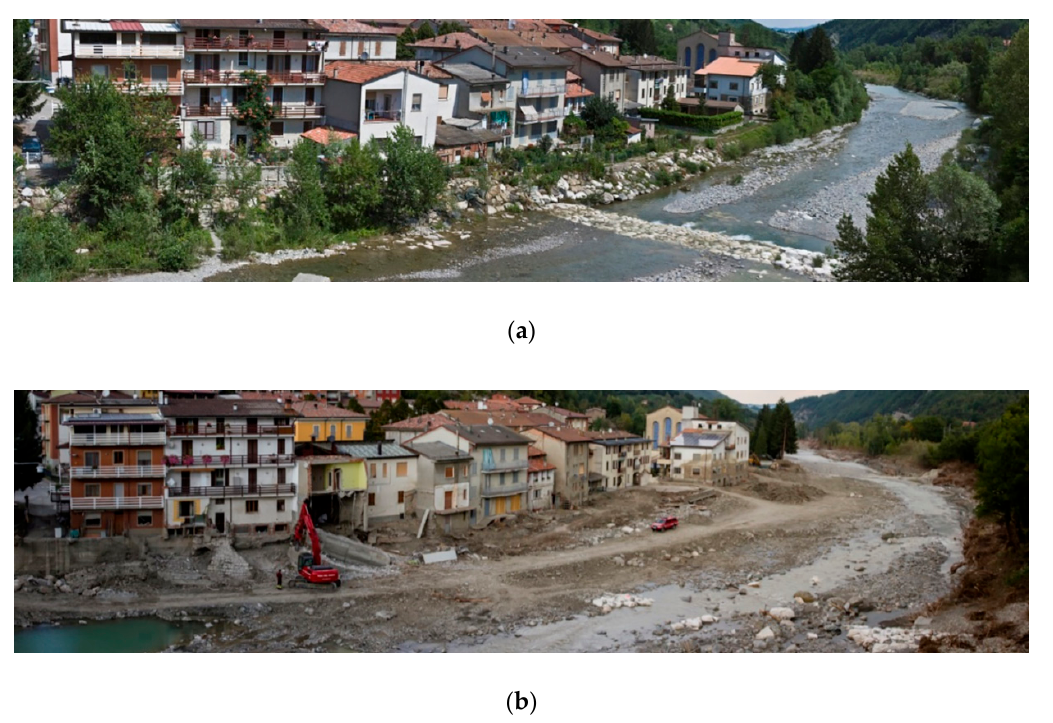
Figure 10. Farini village ( a ) before and ( b ) after the flooding event of 13–14 September 2015.